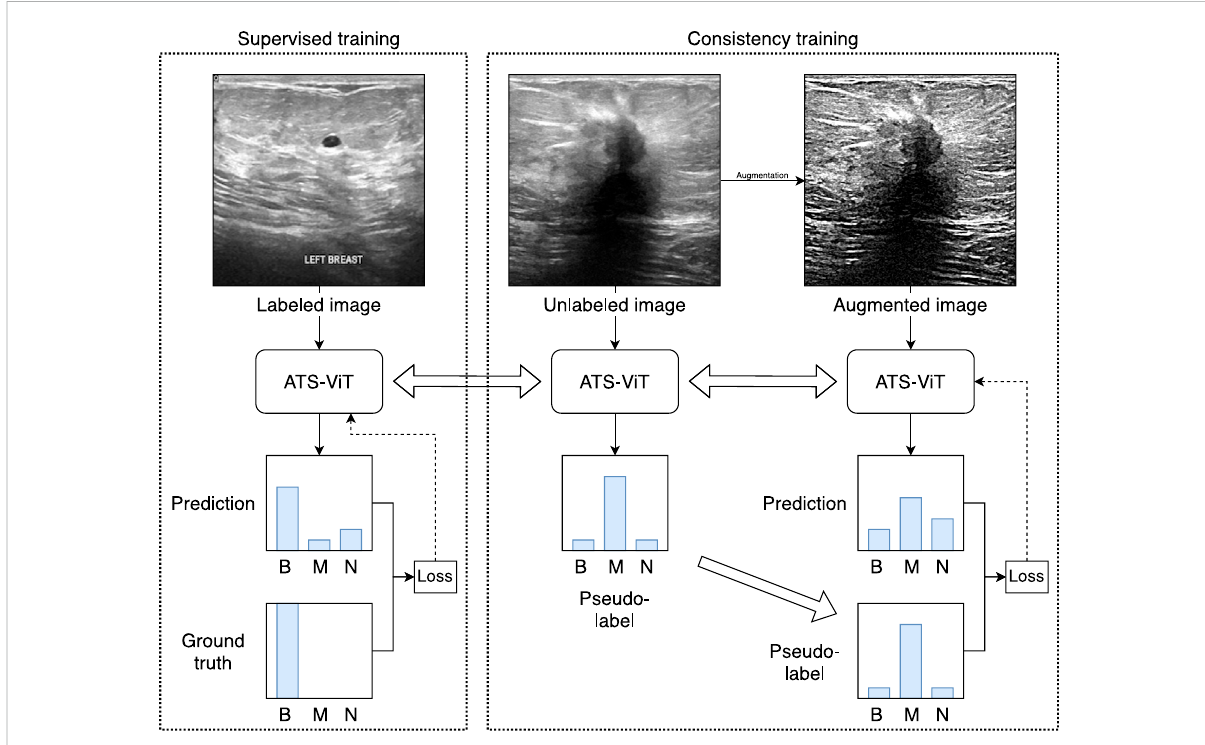
FIGURE 3 Overview of the proposed learning framework. The framework comprises supervised and consistency training uni fi ed via an end-to-end trainingprocedure.Forsimplicity,the fi gureonlyusesimagesamplesfromtheBUSIdataset.Themethodhasbeenvalidatedonbothdatasetsusedin this study.